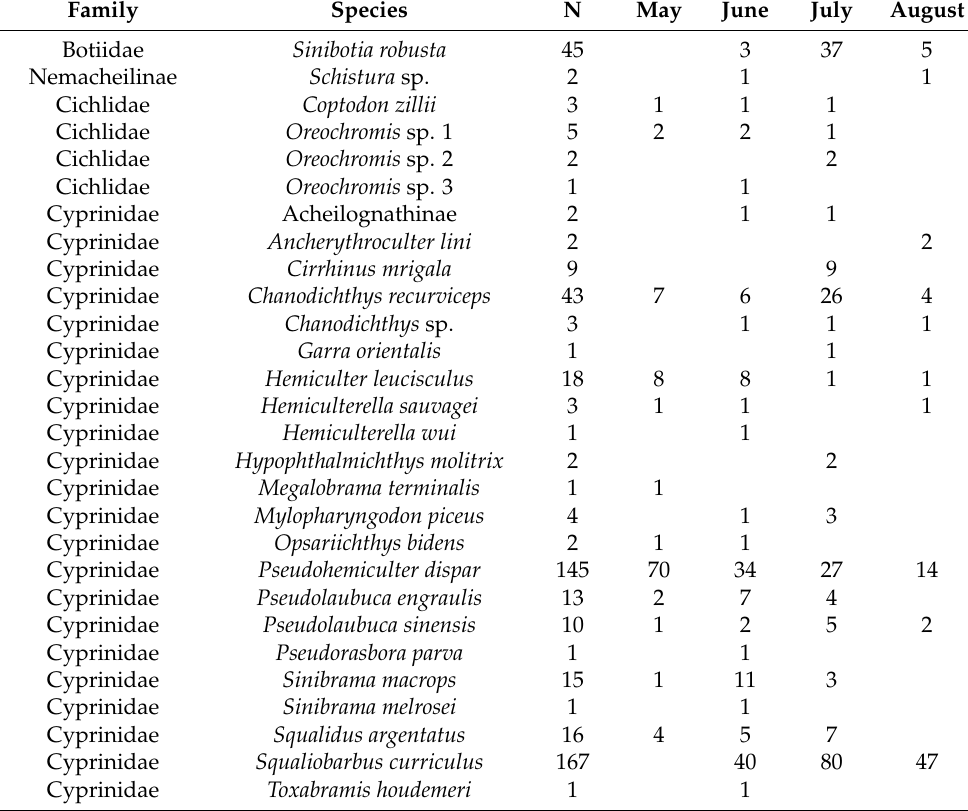
Table 1. The community composition and occurrence times of taxa identified between May and August using DNA barcoding. N, the number of sequences for each species.